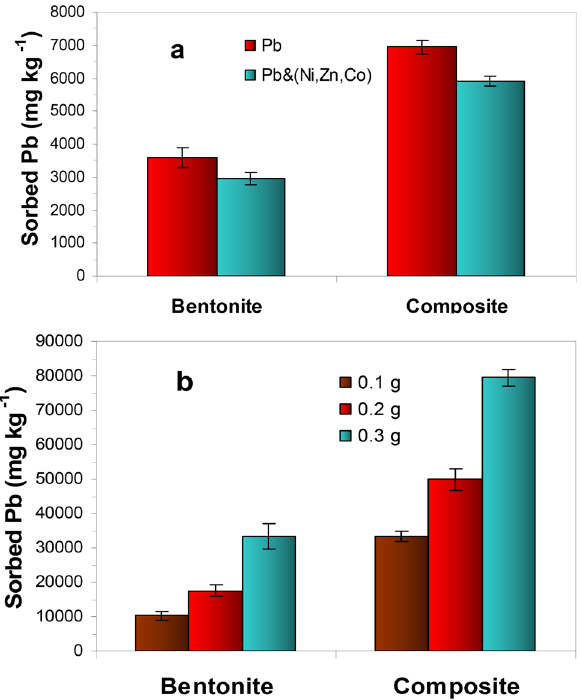
Figure 7. Effect of competitive cations (Ni, Zn, Cu) ( a ), and adsorbent dose (0.1, 0.2, 0.3 g) ( b ) on Pb(II) adsorption by the two